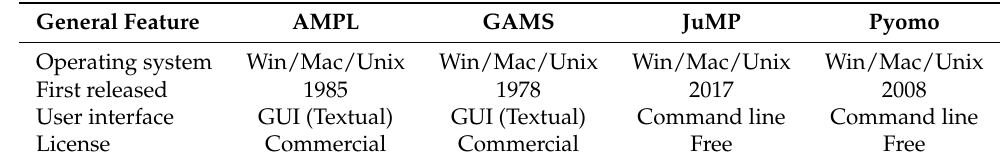
Table 1. General features of AMPL, GAMS, Pyomo, and JuMP software